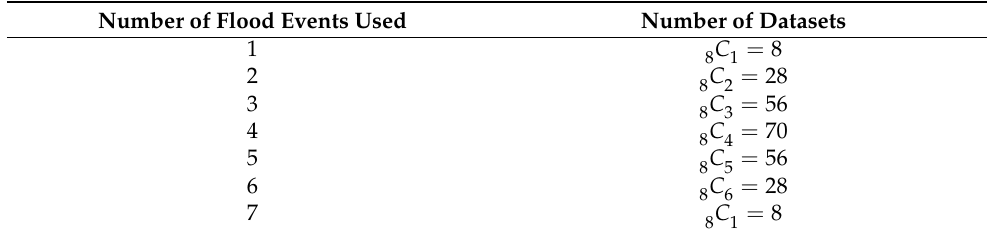
Table 2. Number of events used for parameter estimation. Number of Flood Events